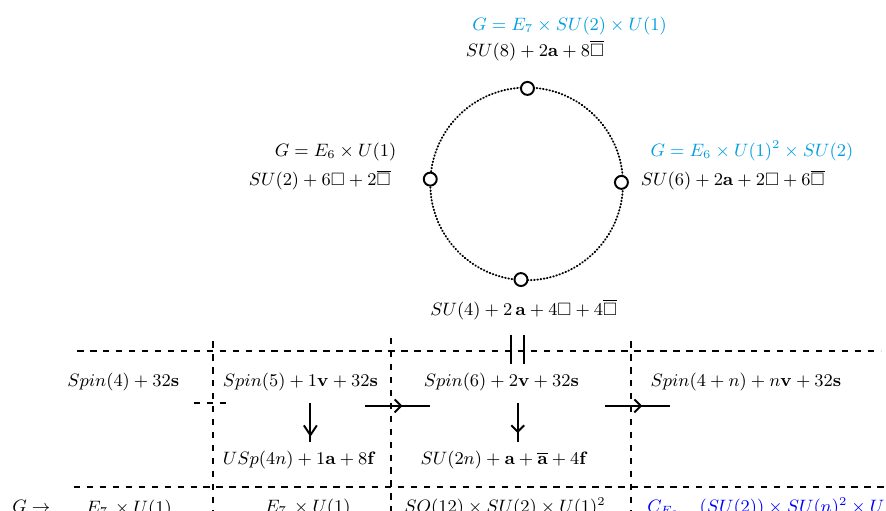
Figure 1. The main sequences of theories and symmetry enhancements that we will discuss. The Spin(4) model, the E 7 surprise [15], is equivalent to the Spin(5) model as they reside on the same conformal manifold. Here C E (SU(2)) is the centralizer of SU(2) in E 9 (cid:0) n . The theories 9 (cid:0) n and/or enhancements colored in shades of blue are new to this paper while others appeared in other references. Here s denotes components in the spinor representation, v vector, a is two index antisymmetric, and f (cid:13)avors which is the number of fundamentals for USp and fundamentals plus anti-fundamentals for SU . The (cid:13)avor symmetry is denoted by G . The symmetry of the SU(2 n ) sequence with n > 2 is expected to be SO(12) (cid:2) U(1) (cid:2) U(1) 2